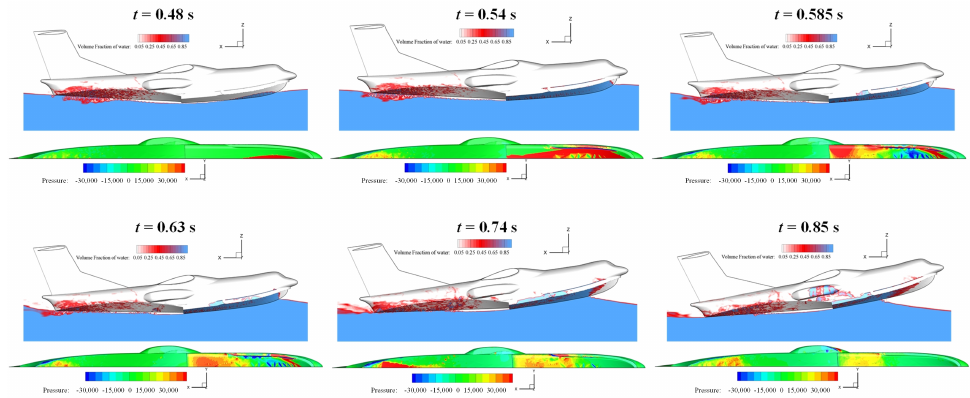
Figure 13. Time-snapshots of flowfield of aircraft landing in wave field during the second impacting and pitch-up stage: the first and third lines are air-water phase contours; the second and fourth lines are corresponding pressure distributions at bottom surface of